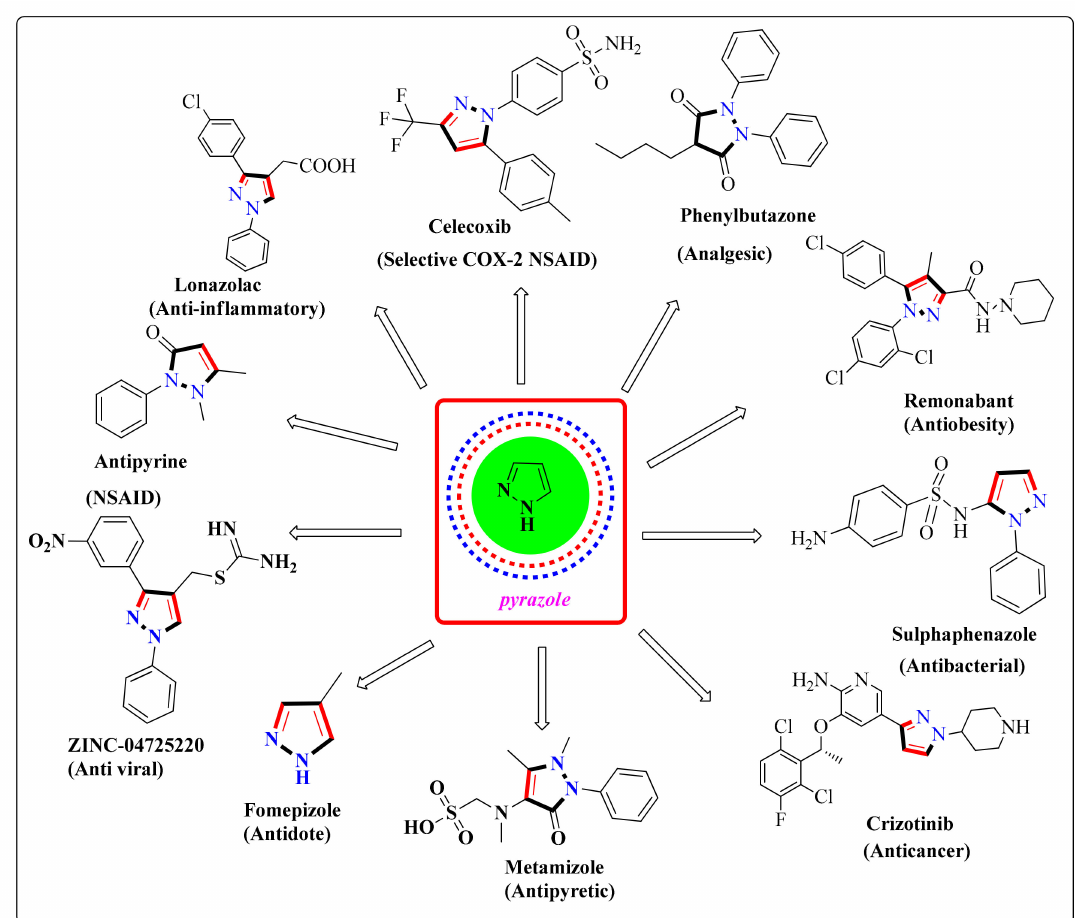
Figure 3. The pyrazole scaffold, exhibiting various pharmacological